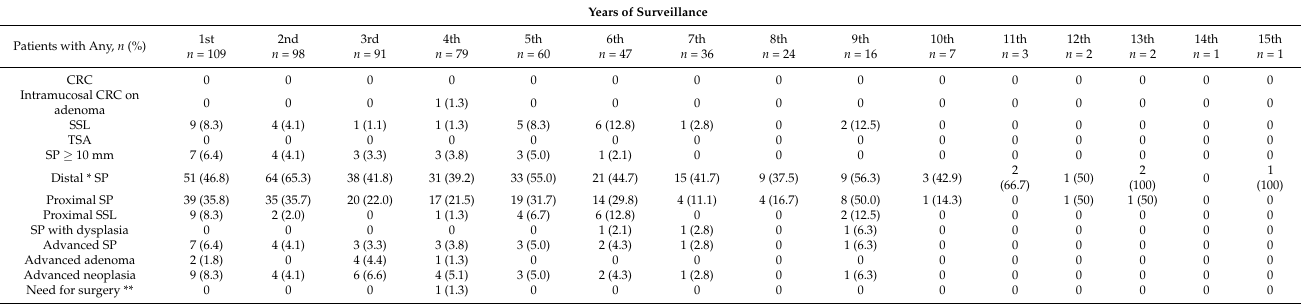
Table 3. Findings in surveillance colonoscopies (per-patient analysis).